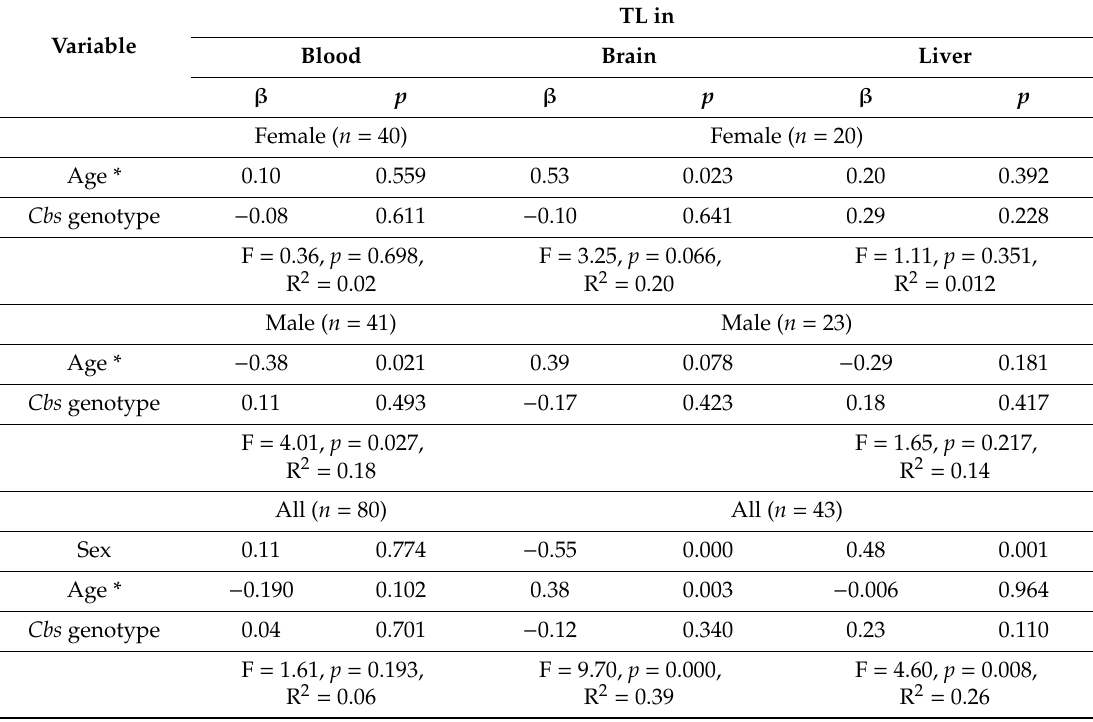
Table 2. Determinants of TL in mouse blood, brain, and liver: multiple regression